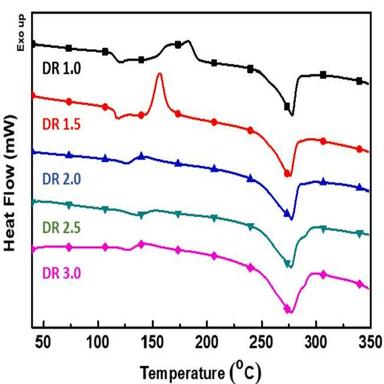
DSC thermograms of PCTN copolymer films obtained after biaxial stretching.